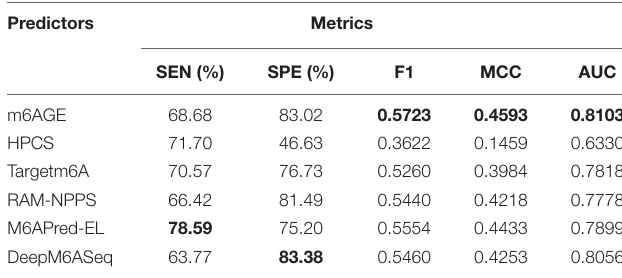
TABLE 2 | The performance of different predictors on S21 dataset.